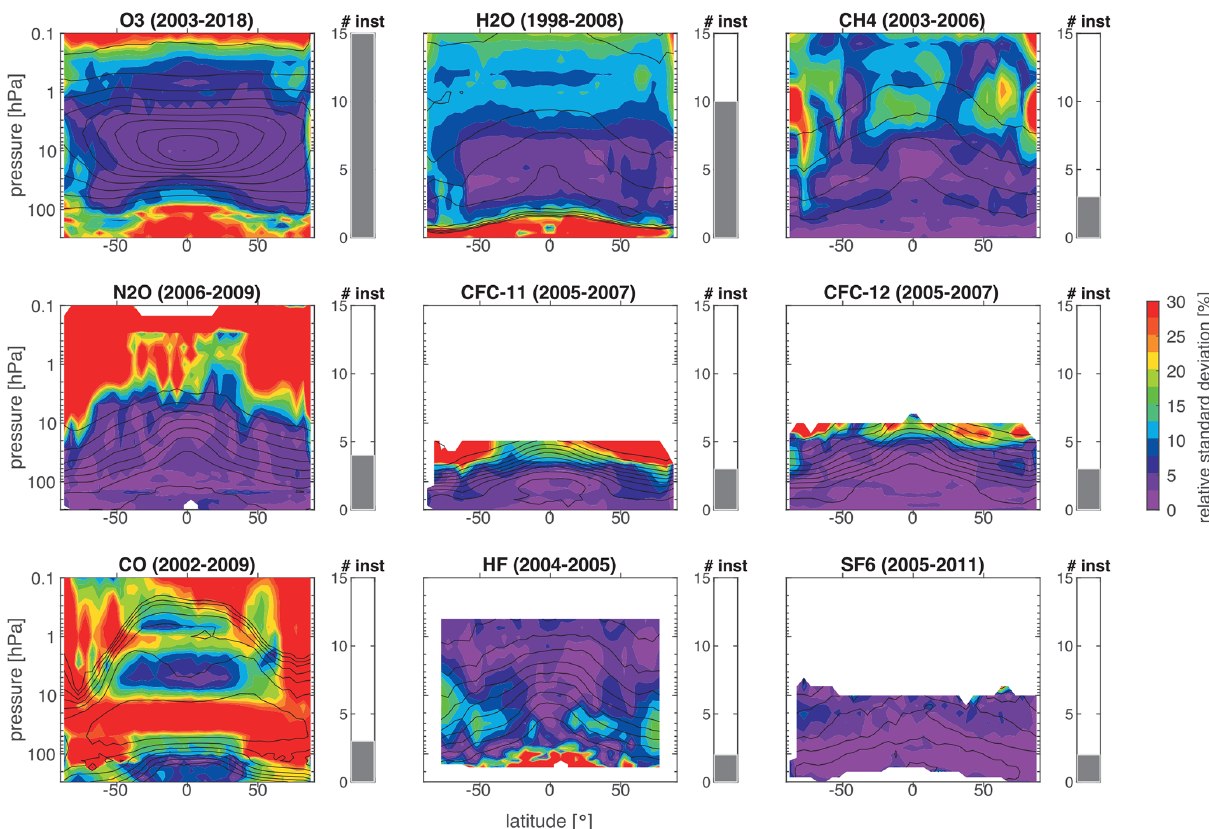
Figure 15. Synopsis of the uncertainty in the annual zonal mean state of the longer-lived species evaluated within the SPARC Data Initiative. The relative standard deviation over all instruments’ multi-annual zonal mean datasets is presented for different chemical trace gas species (color contours). The relative standard deviations are calculated by dividing the absolute standard deviations by the MIM. The black contour lines in each panel represent the MIM trace gas distribution for each species. The number of instruments included is given by the right-hand grey bar. Note that the time periods used depend on the availability of the instruments included in the assessment and hence differ from trace gas to trace